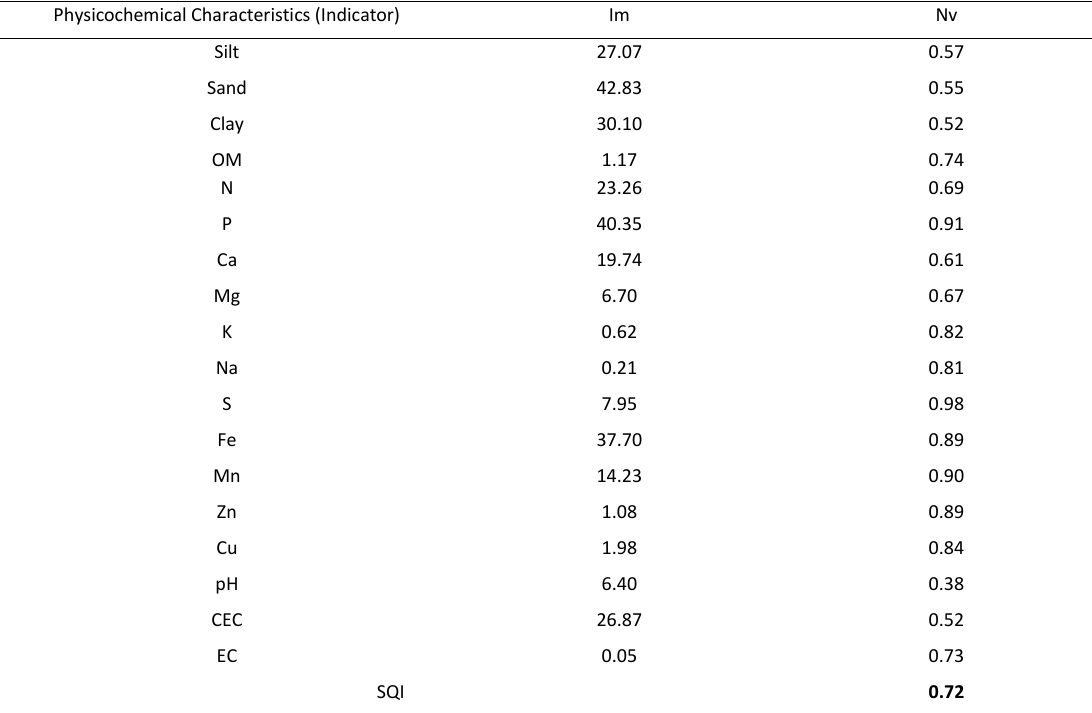
Table 7: SQI in the department of Sucre (Northern Colombia).